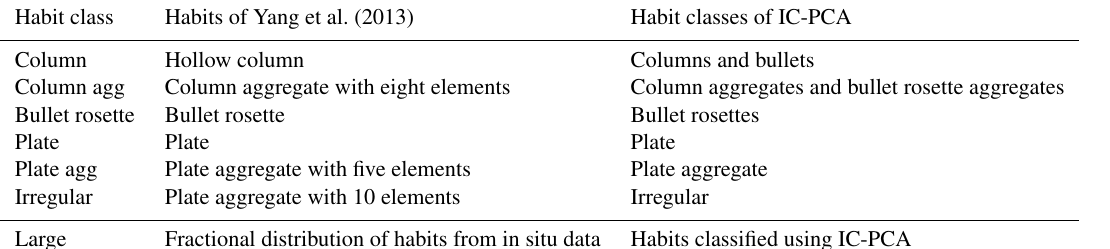
Table 1. The final habit classes of large ice crystals that are created by combining habit classes of the IC-PCA and further interpreted as Yang et al. (2013) habits. In addition to the IC-PCA-based habit distributions, large A and large B , six single-habit distributions are used to describe the shape of large ice crystals.